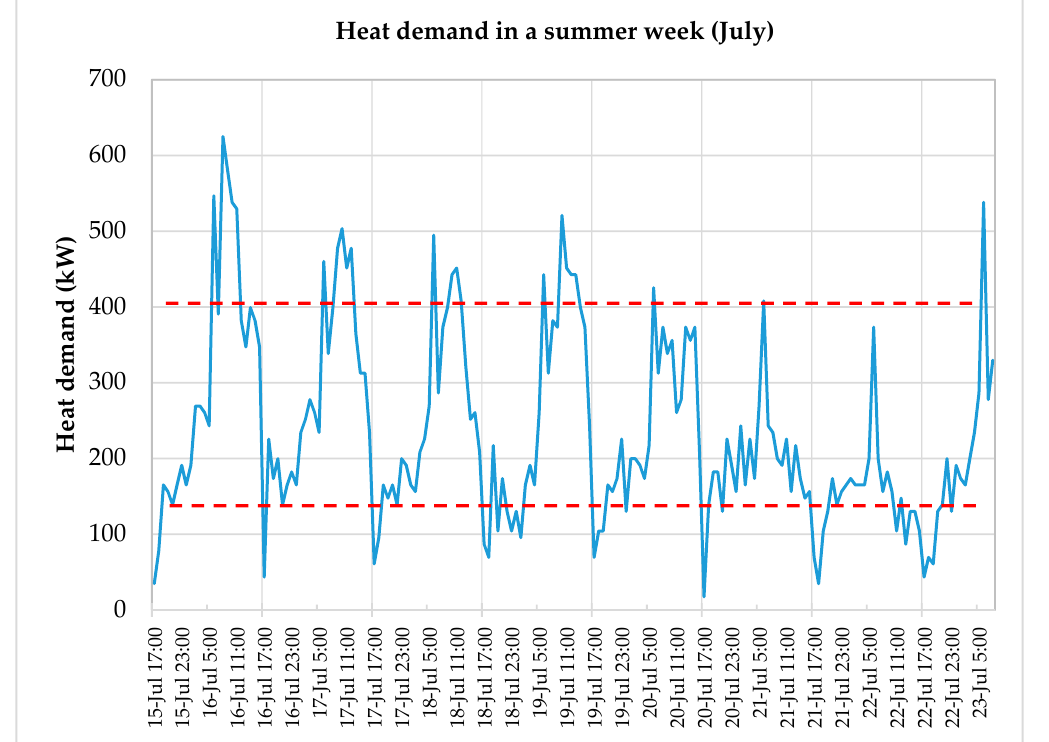
Figure 13. Heat demand in a summer week (July).